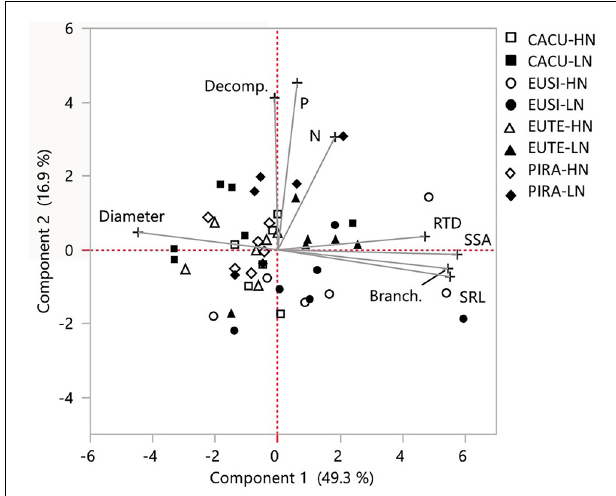
FIGURE 4 | Principal component analysis on the responses to water availability of root chemical and morphological traits and root decomposition. Responses to water availability assessed as the ratio between the value of each variable at LW (low water) and HW (high water). Data points correspond to responses within each experimental shelter (replicates) for each species and each nutrient condition (HN, high nutrients; LN, low nutrients). SRL, specific root length; RTD, root tissue density; SSA, specific surface area; Branching, number of forks/branching points; P, Phosphorus concentration; N, Nitrogen concentration. Values in parentheses: percentage of variation explained by each component. CACU , Casuarina cunninghamiana ; EUSI, Eucalyptus sideroxylon ; EUTE, Eucalyptus tereticornis ; PIRA, Pinus radiata .